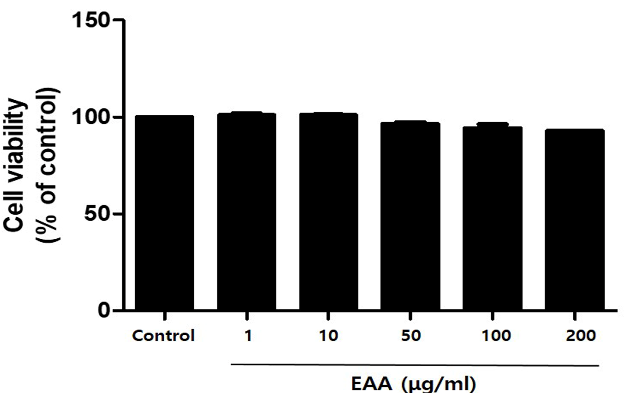
Figure 1. Cytotoxicity of EAA in HaCaT cells. Cytotoxic effects of EAA at different concentrations on HaCaT cells were determined using MTT assays. Results are expressed as a mean percentage in the treated cells compared to the control (solvent) ± S.E. of three independent experiments performed in triplicates.